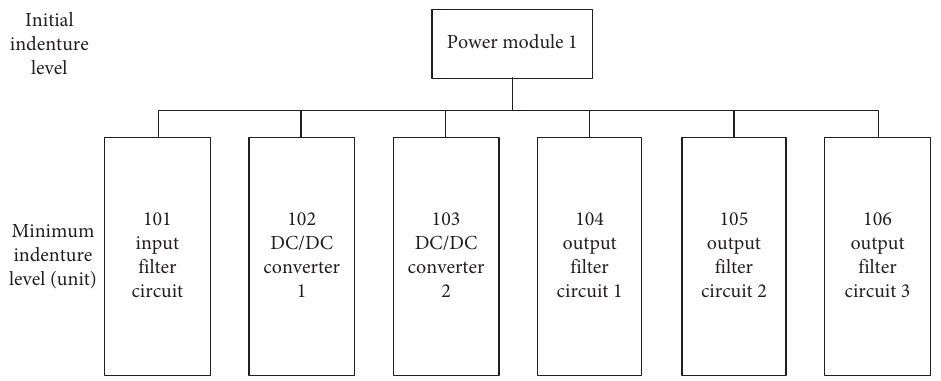
Figure 7: Schematic diagram of power module